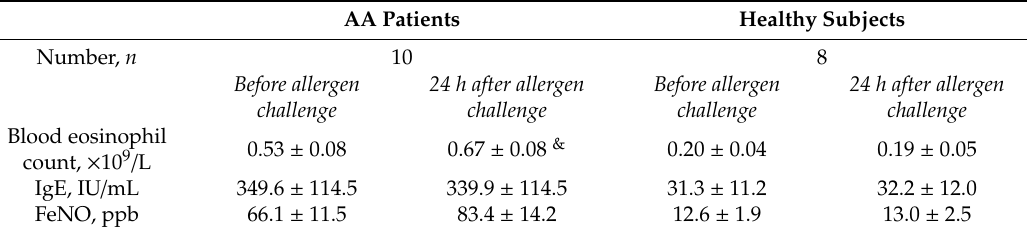
Table 2. Clinical characteristics of the study population after bronchial challenge with D. pteronysinnus. AA Patients